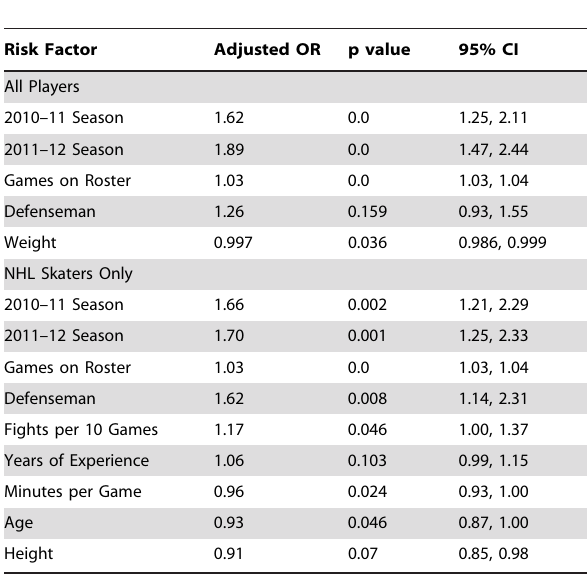
Table 4. Risk factors for suffering a concussion or suspected concussion during the regular